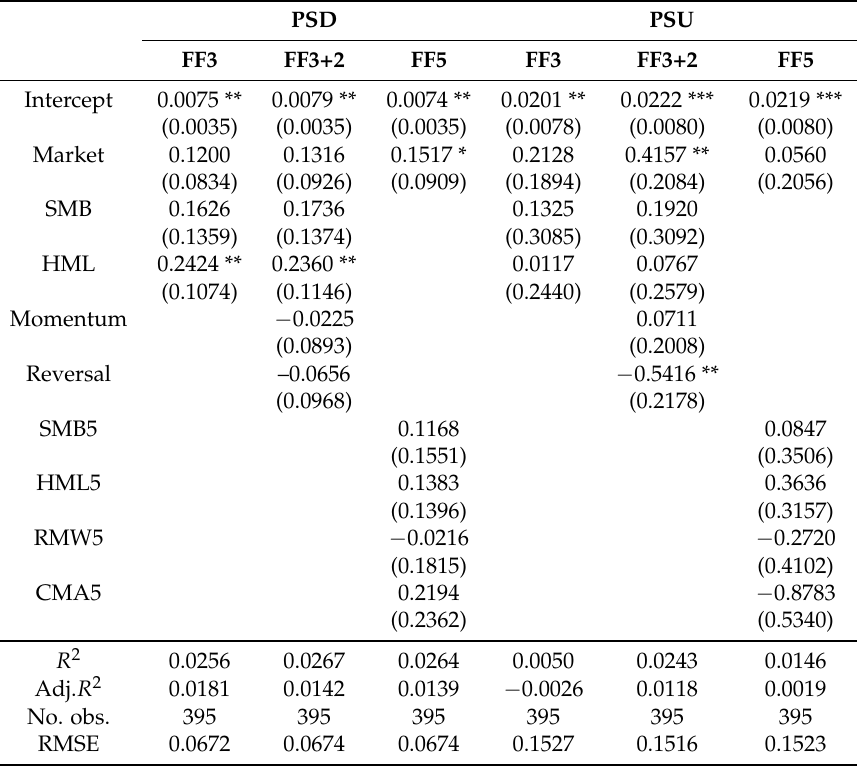
Table 7. Risk factor exposure of PSD and PSU. The standard error is reported in brackets. FF3, Fama–French three factor model; SMB, small minus big capitalization stocks; HML, high minus low book-to-market stocks; RMW, robust minus weak; CMA, conservative minus